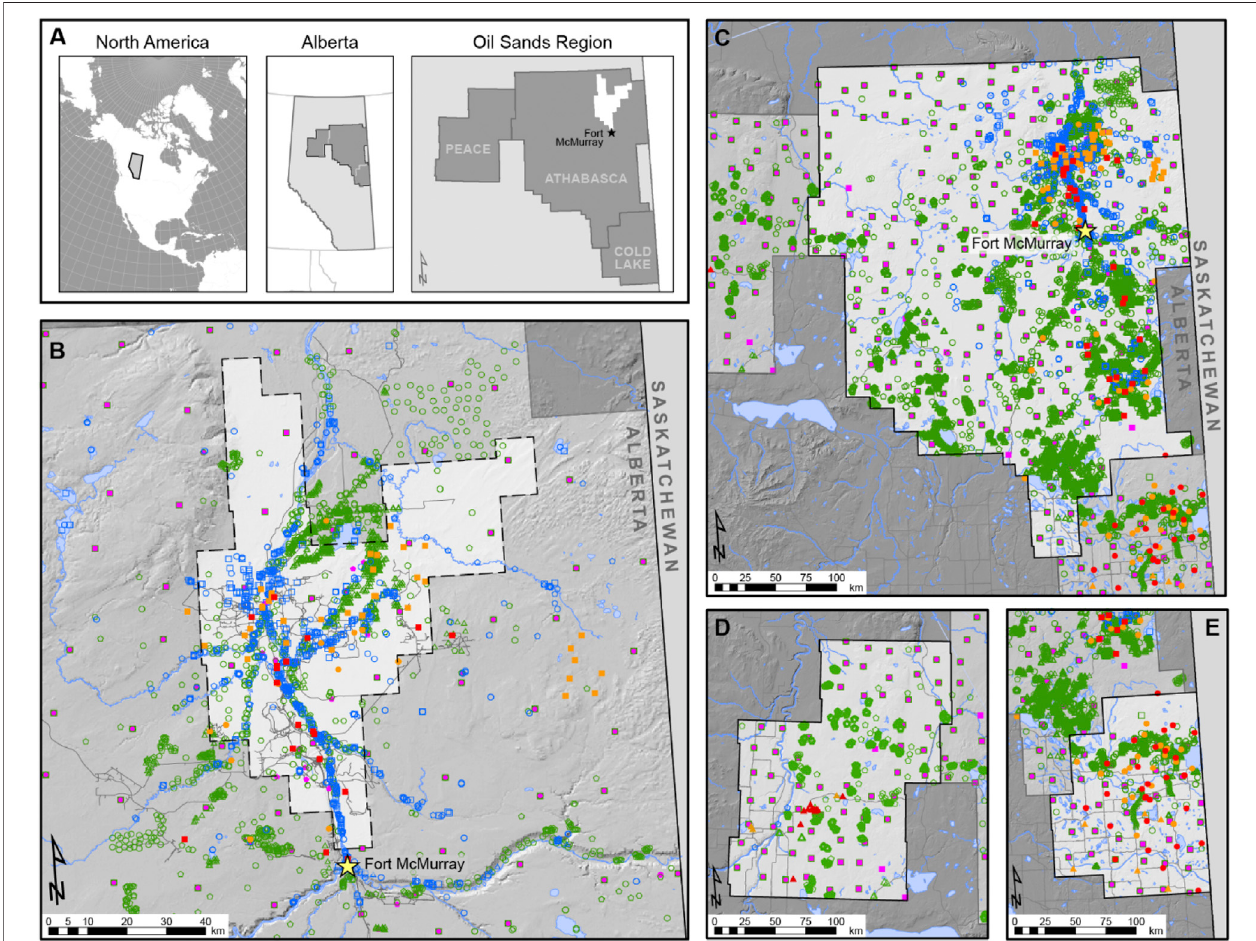
FIGURE 1 | Locations of monitoring areas and activities done under OSM in the OSR of north eastern Alberta; (A) : Key maps showing location in North America; (B) : Map of the surface minable area (white polygon with dashed outline; (C) : Map of the Athabasca OS Region (D) : Map of the Peace OS Region; (E) : Map of the Cold Lake OS Region; Environmental monitoring sites are shown as colored points (green (cid:1) land; blue (cid:1) water; red (cid:1) air; orange (cid:1) groundwater; purple (cid:1) wetlands), with shapes representing different monitoring partner organizations.